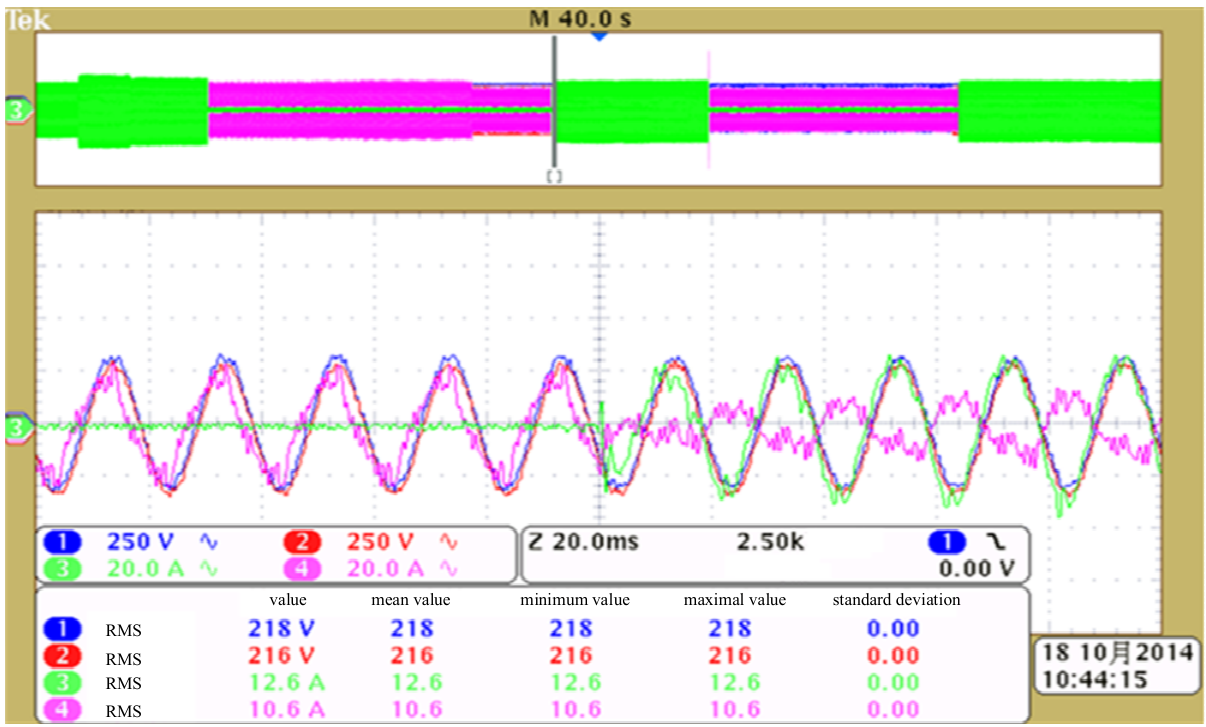
Figure 9. Conversion of the autonomous mode to the grid-connected